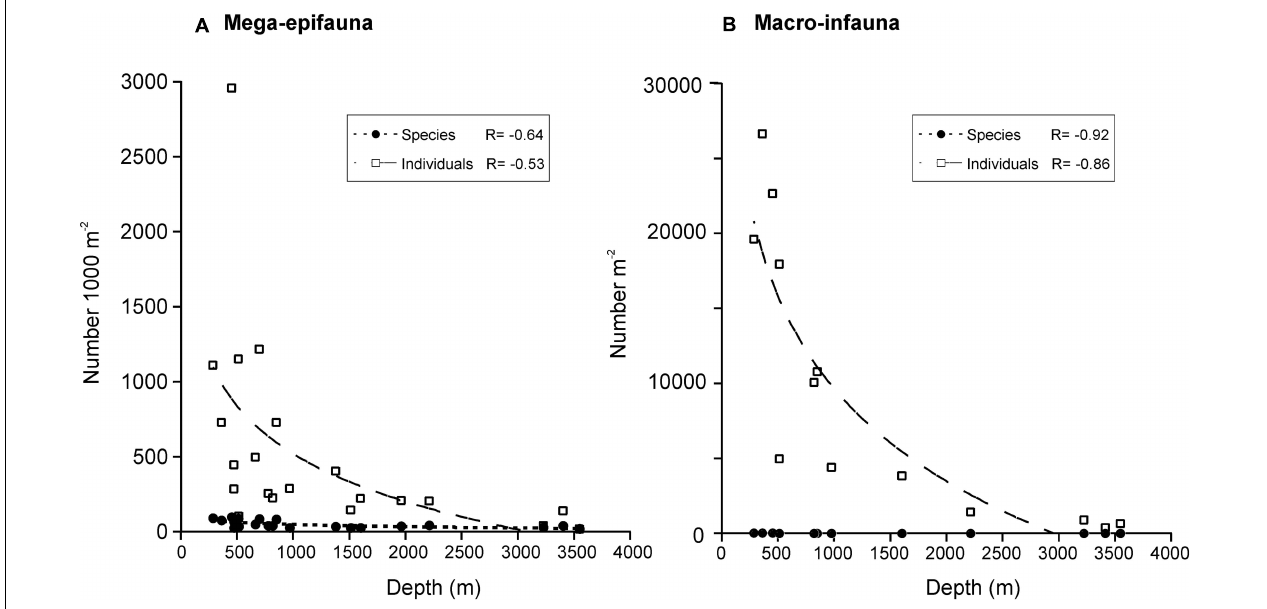
FIGURE 4 | Relationship between depth and number of (A) mega-epifaunal and (B) macro-infaunal taxa and individuals. Curves are logarithmic fits and correlation coefficients (R) are shown for each. Mega-epifaunal data from DTIS video footage.